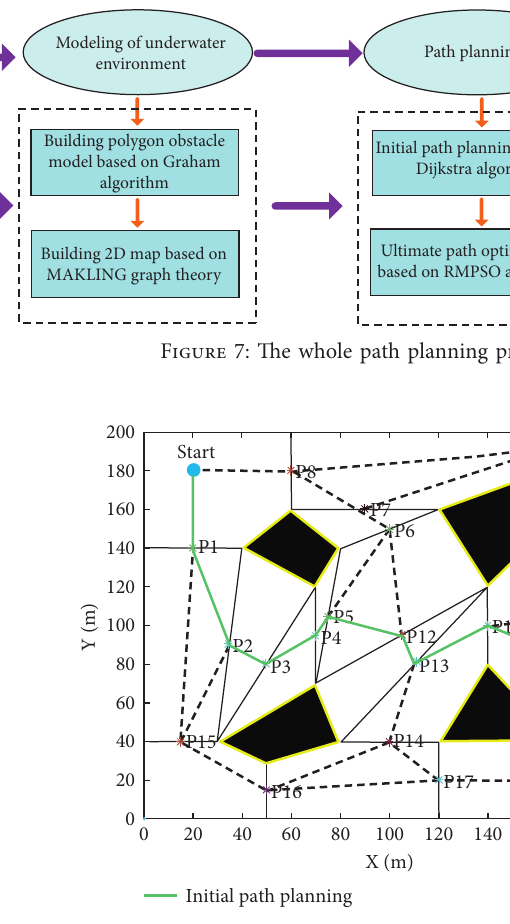
Figure 8: Initial path planning (Dijkstra algorithm).